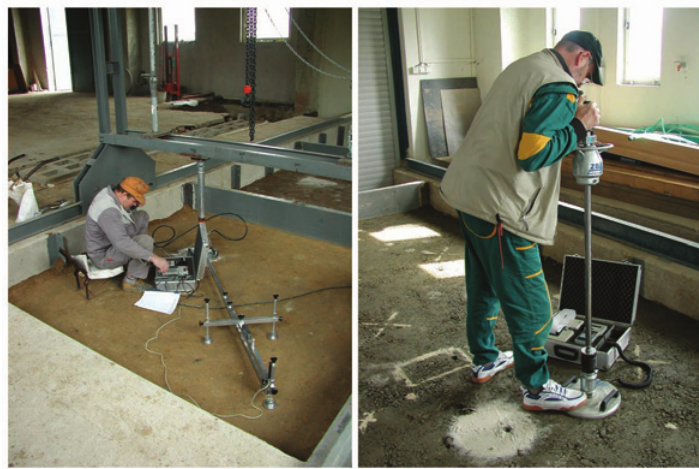
fig. 7. Tests in the GLTF: static plate test (left) and dynamic LFWD test (right) table 1. Soil tested Test set